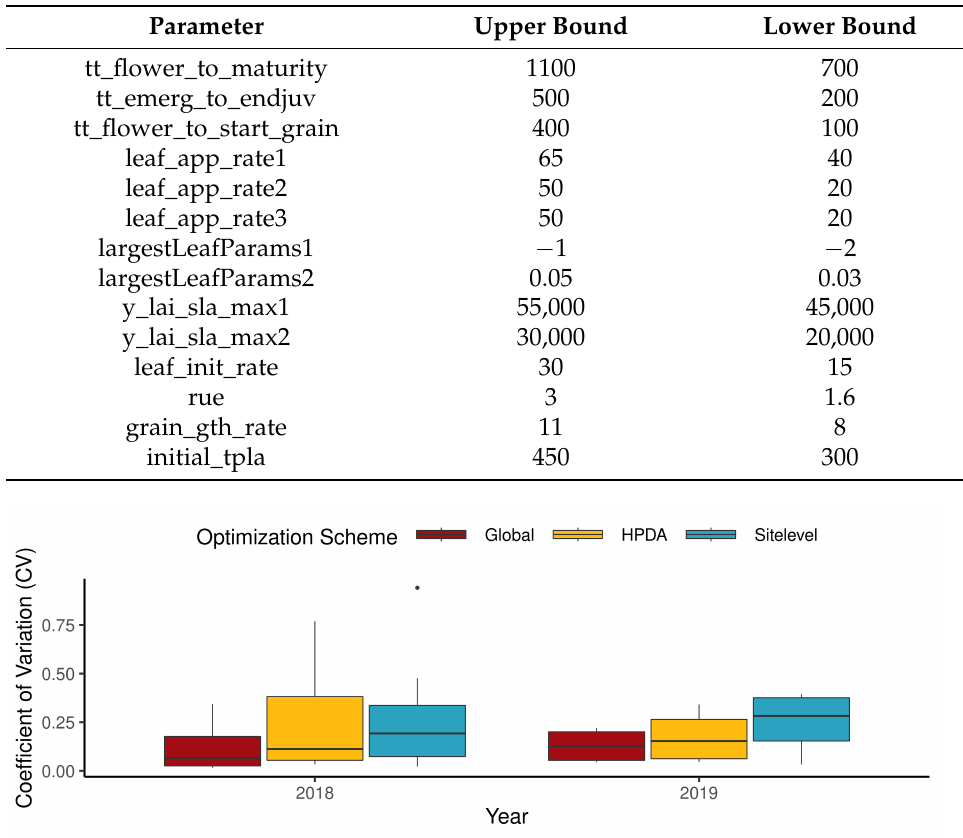
Table A3. List of initial candidate parameters used in the global sensitivity analysis